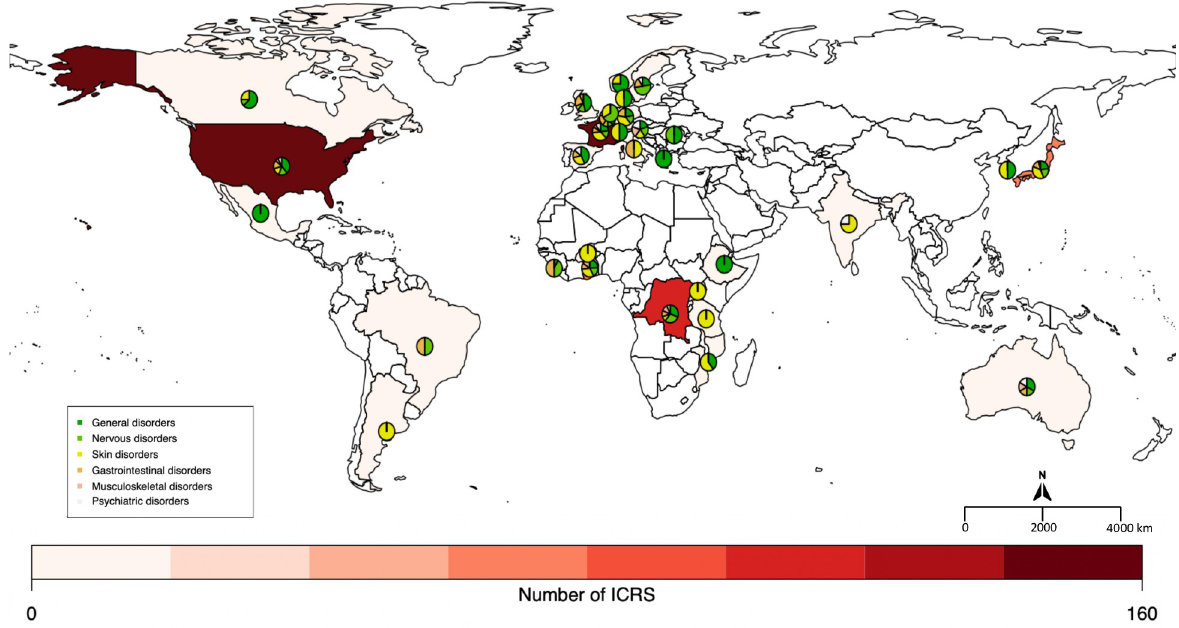
Fig 1. Number of Individual Case Safety Reports (ICSRs) per country and distribution of sADRs of the 6 most reported SOCs (created with R software and the Rworldmap package). The pie charts show the proportion of the most reported SOCs described by country. The number next to the pie chart represents the number of ICSRs by country (an ICSR can contain multiple